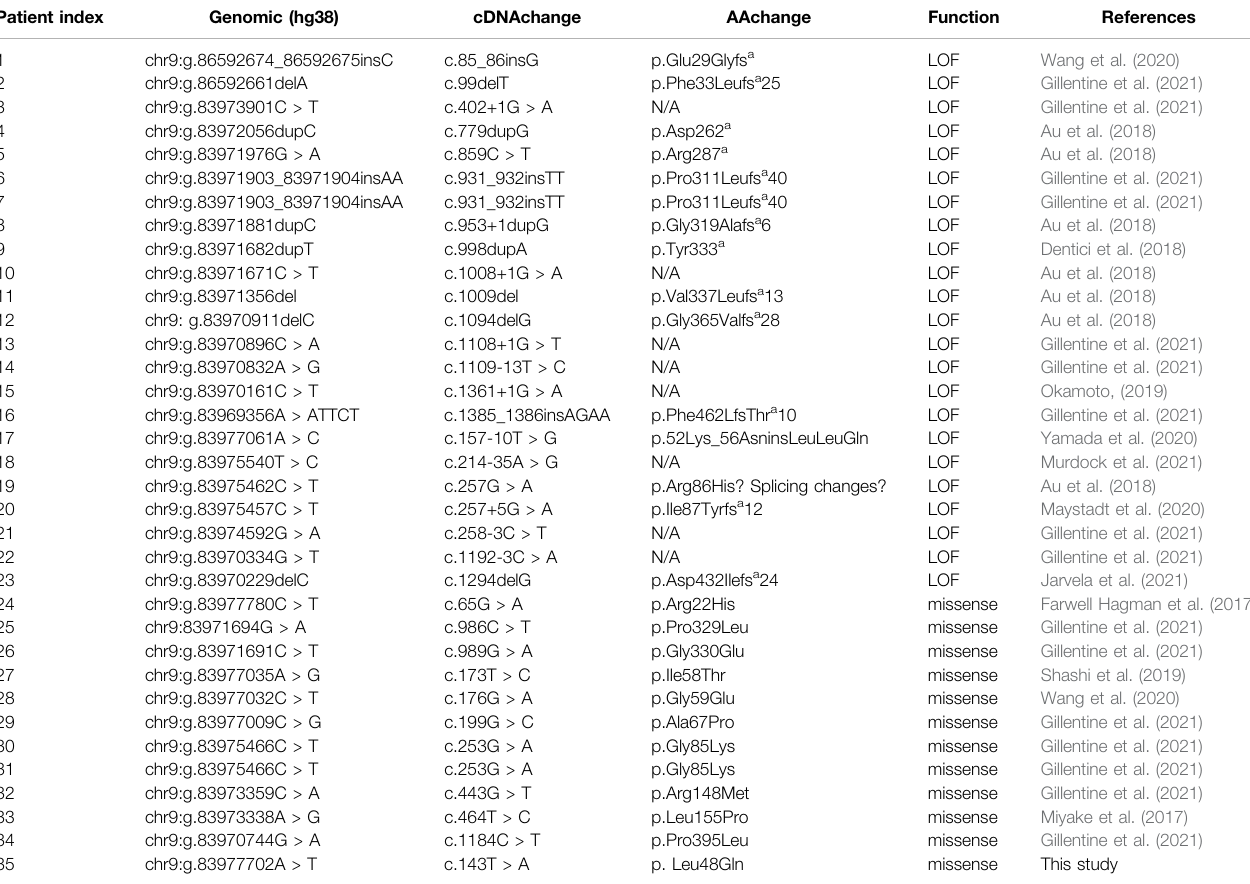
TABLE 1 | Pathogenic variants identi fi ed in HNRNPK gene (NM_002140.3). Patient